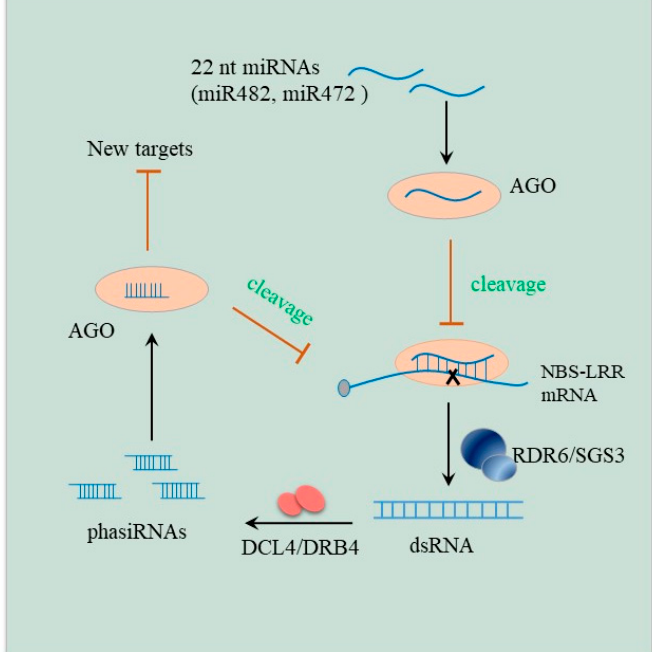
Figure 1. The regulatory network of 22 nucleotides (nt)-long miRNAs and NBS-LRR mRNAs involved in production of phasiRNAs. The 22-nt miRNA guides AGO protein to cleave the target site on the NBS-LRR transcript, triggering dsRNA synthesis mediated by RDR6 (RNA-DEPENDENT RNA POLYMERASES 6) and SGS3 (SUPPRESSOR OF GENE SILENCING 3). dsRNA is subsequently processed by DCL4 (DICER-LIKE 4) and DRB4 (DOUBLE-STRANDED-RNA-BINDING PROTEIN 4) to generate a cluster of 21-nt phased siRNAs (phasiRNAs). These 21-nt phasiRNAs are loaded into AGO proteins, which in turn can lead to NBS-LRR mRNAs cleavage. On the other hand, these siRNAs will depress more new targets.